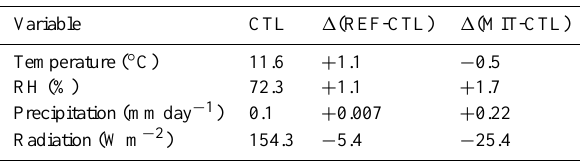
a Annual domain-wide values extracted from 10yr mean of daily averages.